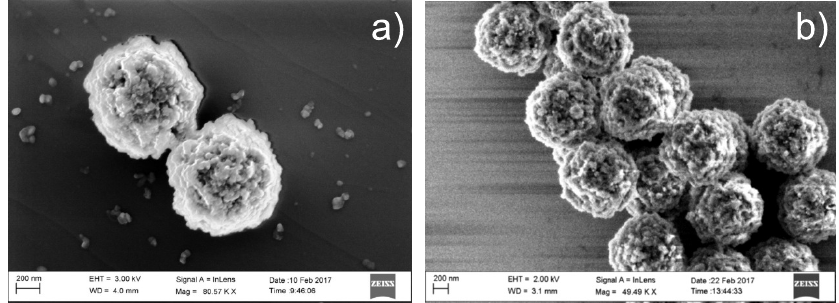
Figure 7. ( a ) Scanning electron microscopy (SEM) image of beads without immobilized antibodies, 86 measurements yielded a mean diameter of 1.03 µ m with an interval of 0.88–1.25 µ m; ( b ) SEM image of beads with immobilized antibodies, 86 measurements yielded a mean diameter of 1.04 µ m with an interval of 0.94–1.14 µ